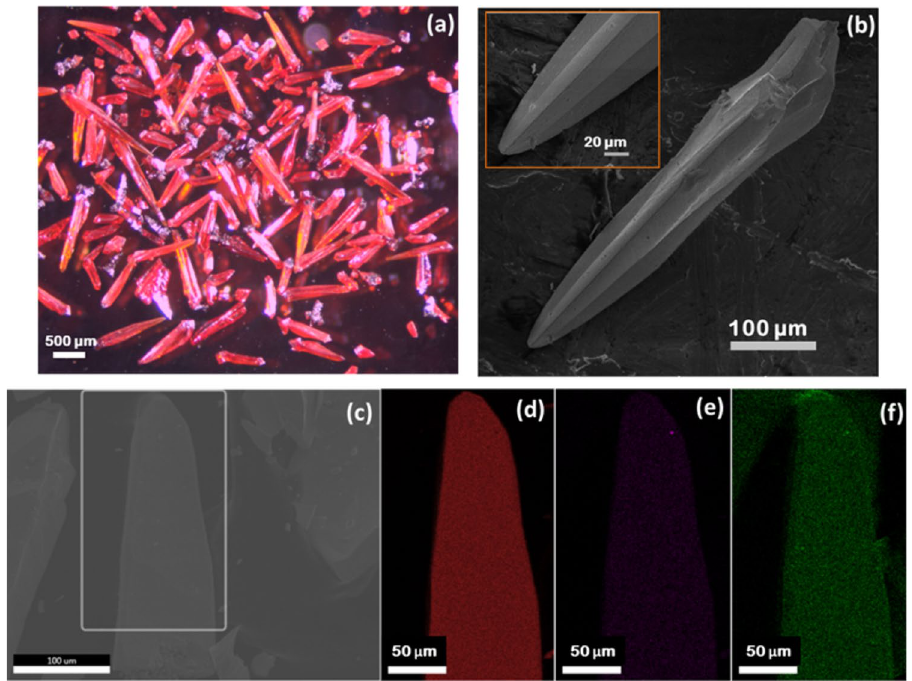
Figure 2. ( a ) Optical microscope image of Bi 12 FeO 20 crystals ( b ) SEM image and the EDS elemental mapping of the BFO crystals ( c ) SEM image of EDS mapped area ( d ) Bi, ( e ) Fe, ( f ) O